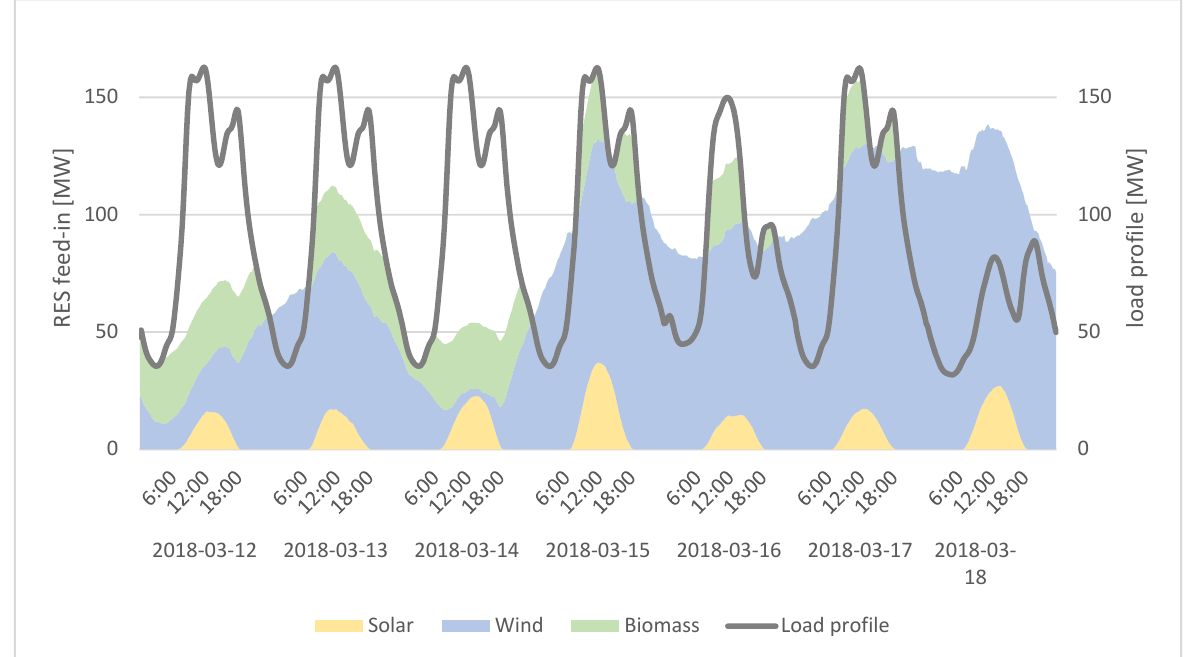
Figure 2. Exemplary week of RES feed-in in an exemplary county. Biomass power is only provided at times when wind and solar power cannot fully cover the local demand.